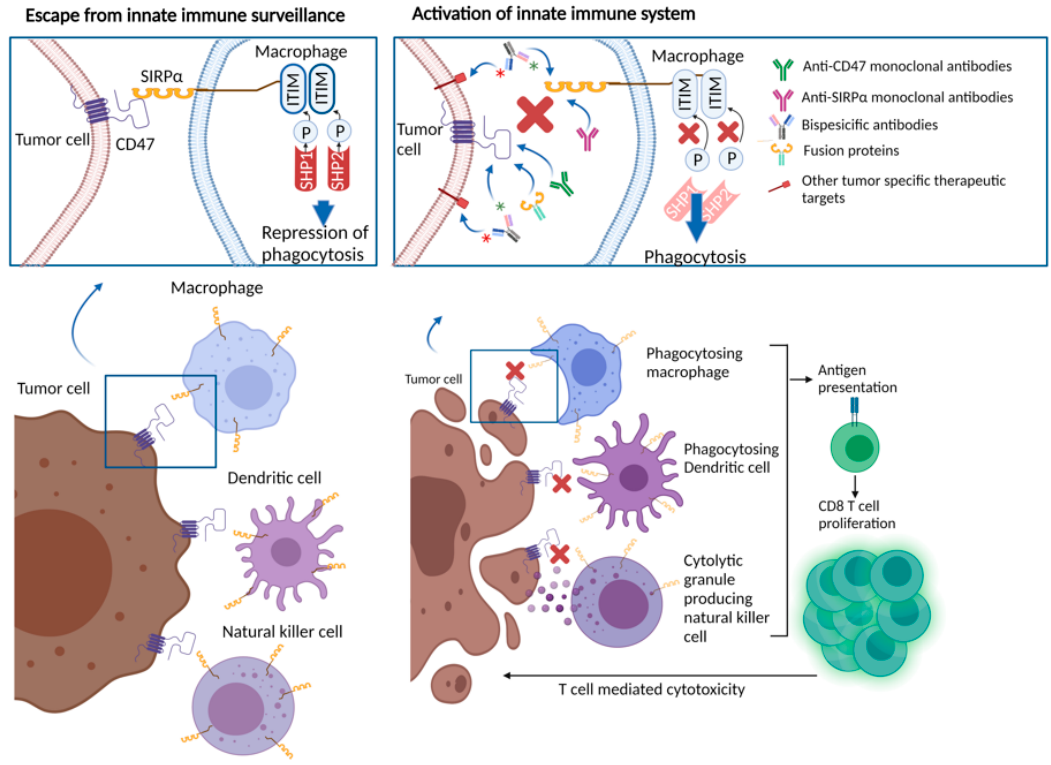
Figure 1. CD47/SIRP α interaction leading to repression of phagocytosis and therapeutic approaches blocking CD47/SIRP α axis.